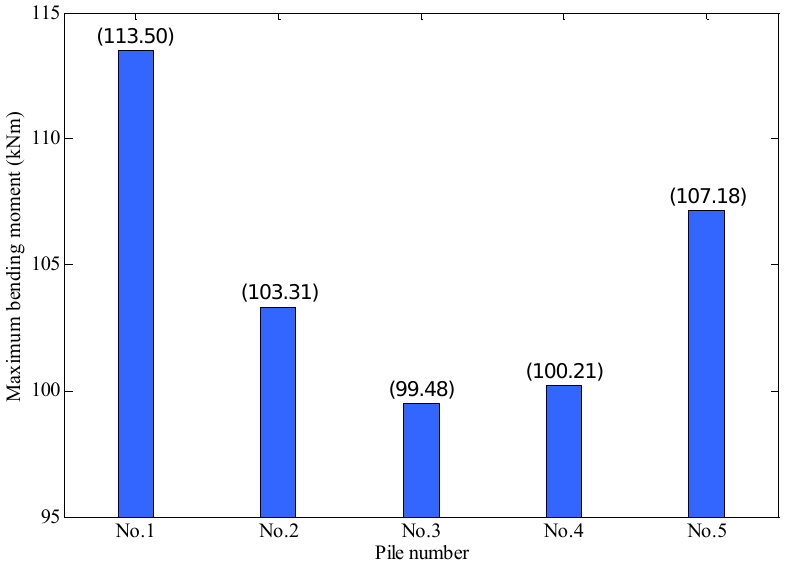
Figure 14. Maximum bending moment of individual anti-slide piles.